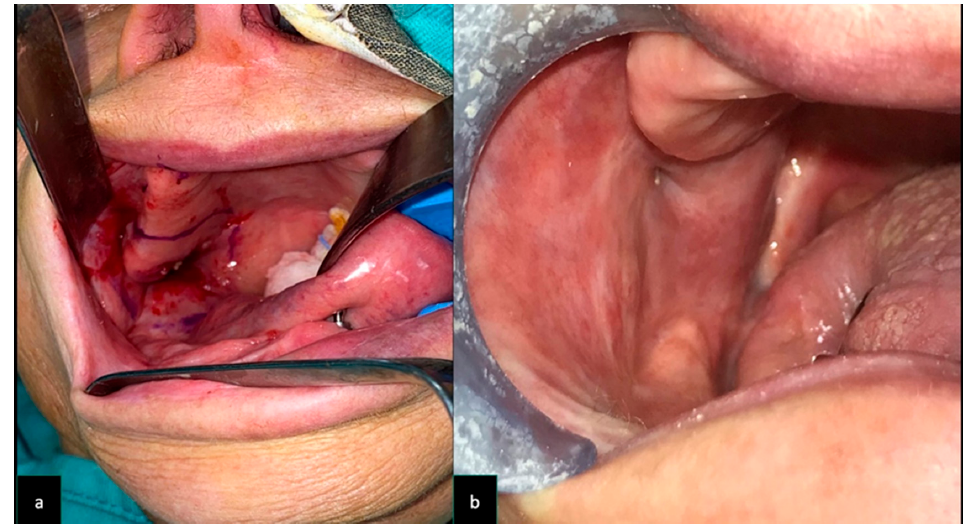
Figure 5. Same patient as Figure 1 (Case 6) ( a ) Intra-oral aspect of the cancer involving right tuber maxillae and cheek. ( b ) The reconstruction performed with STAP flap.